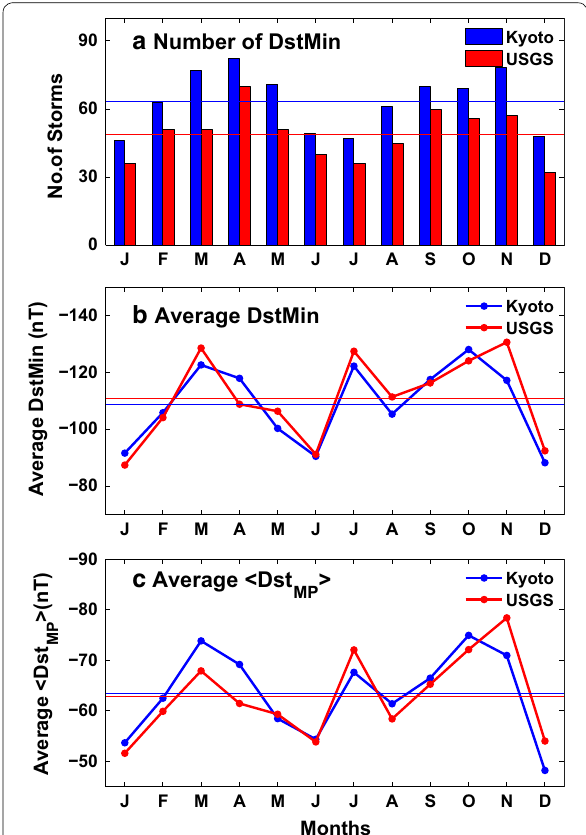
Fig. 4 Overall seasonal variations of monthly number of storms ( a ), and their corresponding average DstMin ( b ) and average ⟨ Dst MP ⟩ ( c ) of the storms in Kyoto Dst ( blue ) and USGS Dst ( red ); large standard deviations of average DstMin and average ⟨ Dst MP ⟩ resulted from combining all storms (moderate to super) in 1958–2007 together are not shown; horizontal lines represent annual means